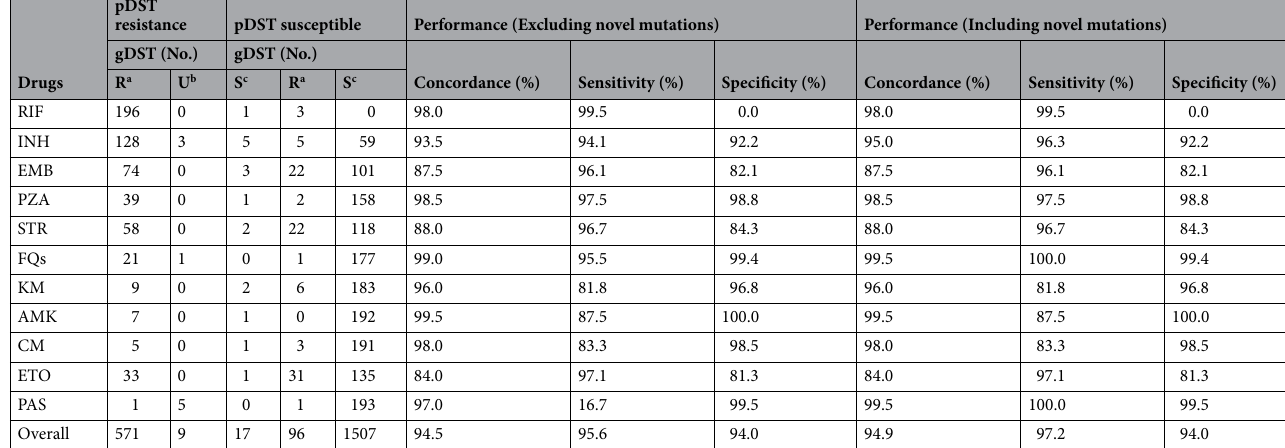
Table 3. Performance of whole-genome sequencing in predicting drug-resistance. RIF rifampicin, INH isoniazid, EMB ethambutol, PZA pyrazinamide, STR streptomycin, FQs fluoroquinolones, KM kanamycin, AMK amikacin, CM capreomycin, ETO ethionamide, PAS para-aminosalicylic acid, pDST phenotypic drug susceptibility testing, gDST genotypic drug susceptibility testing. a R, detection of resistance-associated mutations. b U, detection of novel mutations association with resistance unknown. c S, detection of mutations known not to be associated with resistance (phylogenetic marker or synonymous mutation) or no mutation